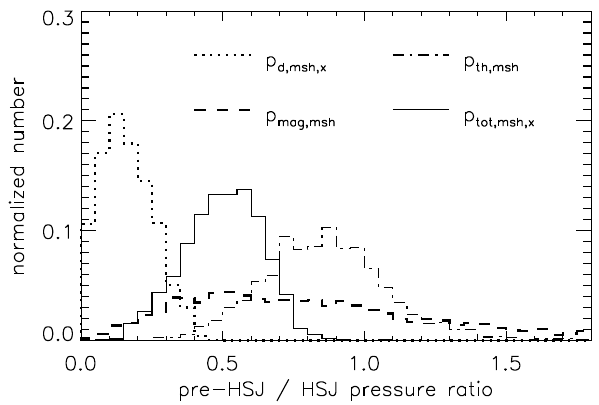
Fig. 10. Distributions of pre-HSJ over HSJ magnetosheath pressure ratios of the dynamic pressure in the GSE x direction ( p d , msh ,x ; dotted line), the magnetic pressure ( p mag , msh ; dashed line), the thermal pressure ( p th , msh ; dash-dotted line), and the sum of the above pressures ( p tot , msh ,x ; solid